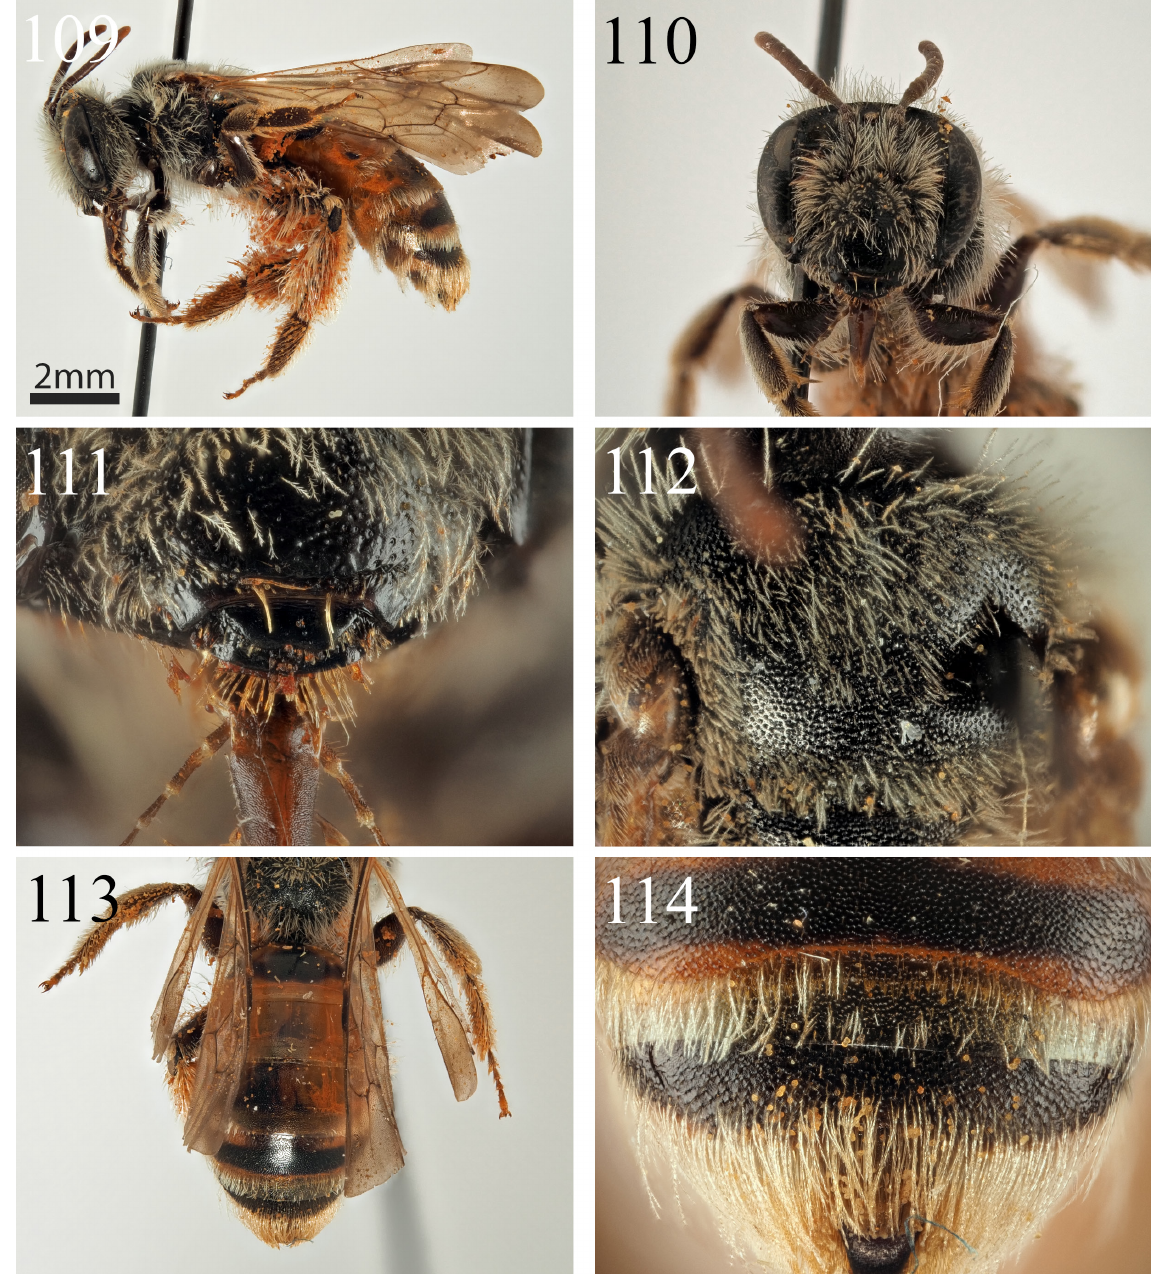
Figs 109–114. Andrena bulbosa Wood sp. nov., ♀ (OÖLM). 109 . Profile. 110 . Face. 111 . Process of labrum, detail. 112 . Scutum. 113 . Terga. 114 . Terga